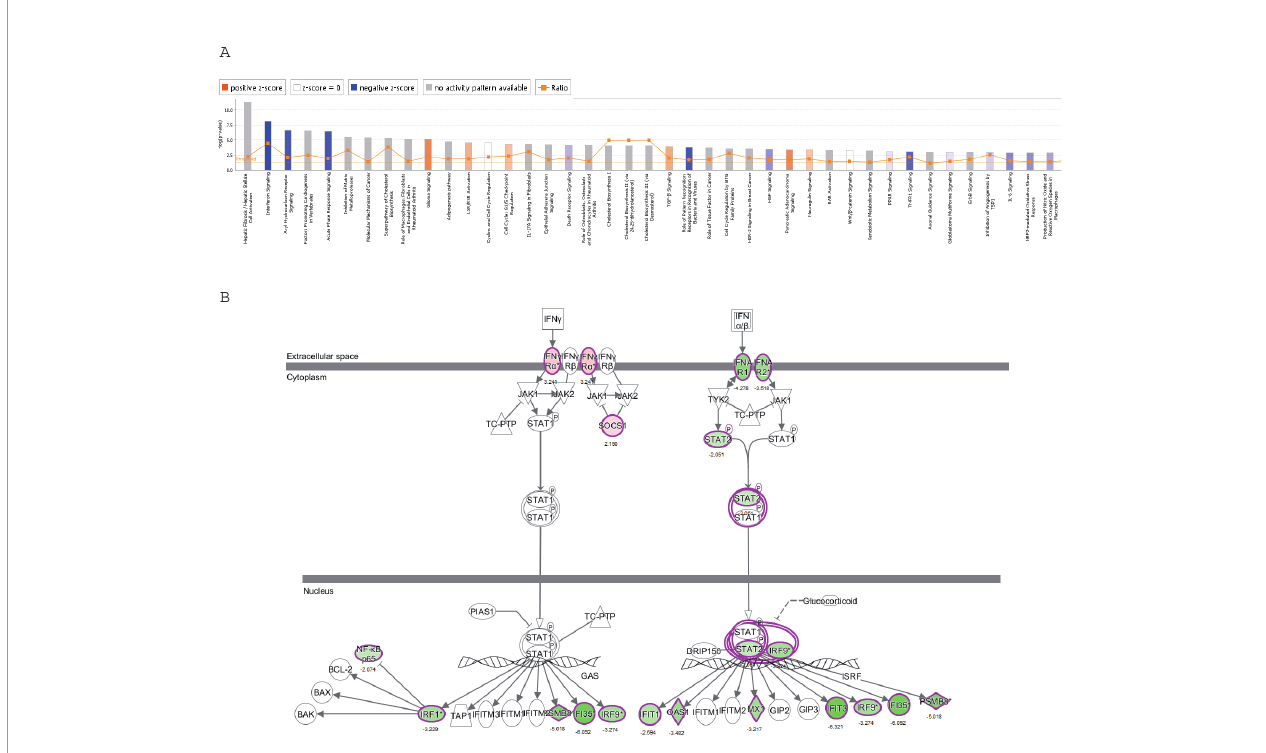
FIGURE 5 | The canonical pathway analysis by IPA ® . (A) The enrichment of the DEGs in the canonical signaling pathway, sorted by – log(P). (B) The effect of experimental data on signal transfer in the interferon signaling